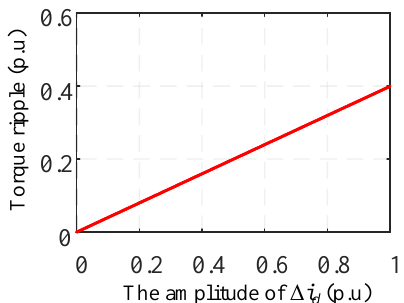
Figure 1. Effect of the injected d -axis current on torque. Figure 1. E ff ect of the injected d -axis current on